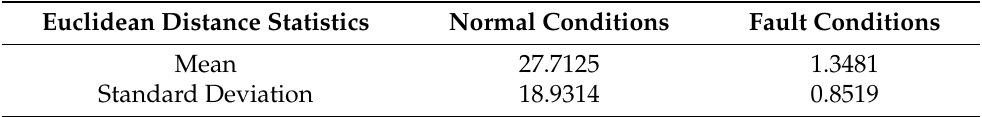
Table 4. 100 Ω fault